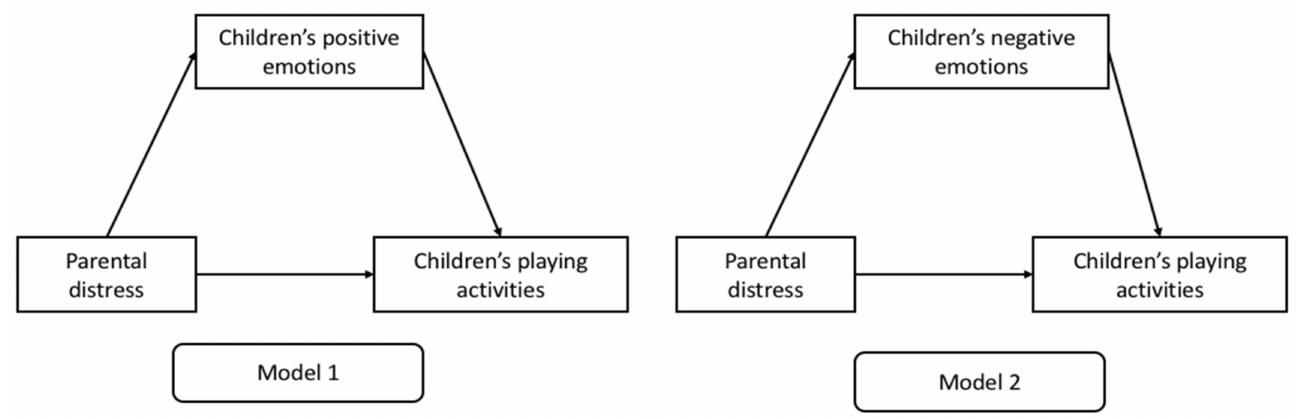
Figure 1. The hypothesized mediation